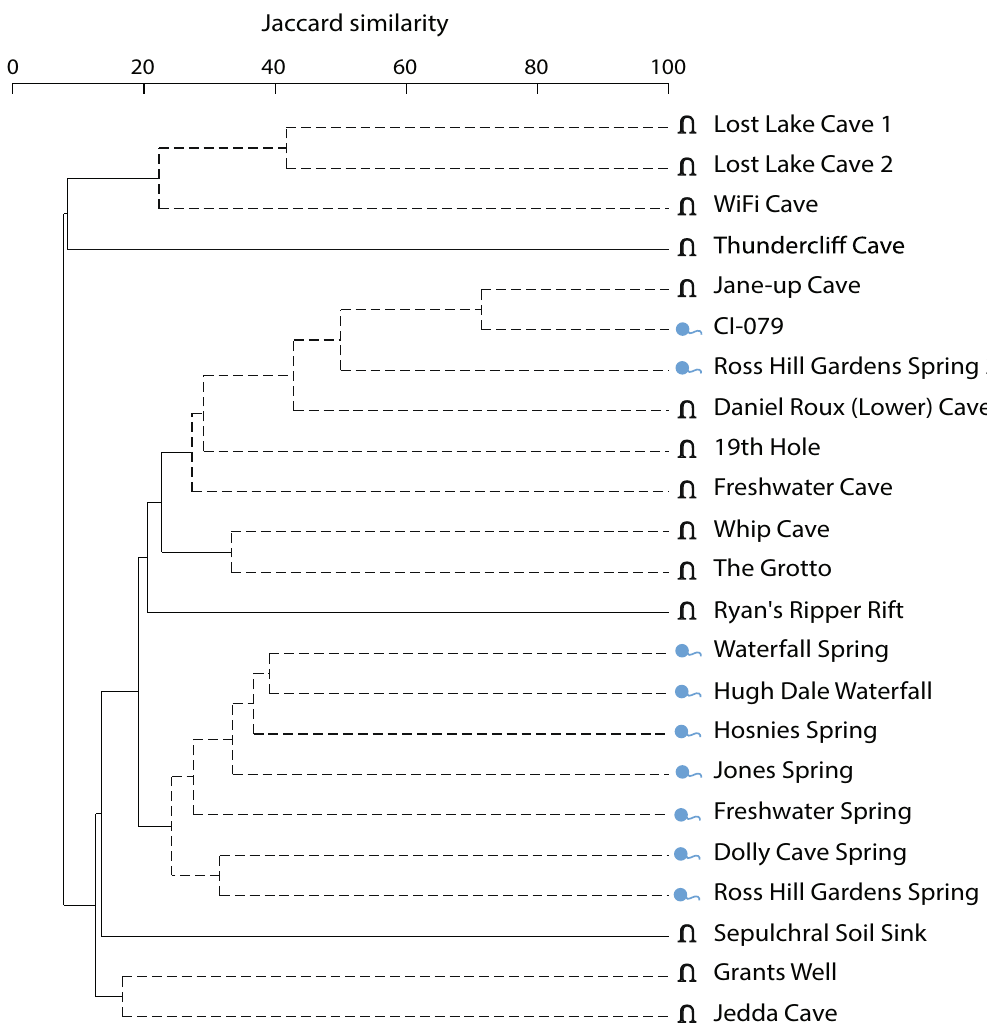
Figure 5. Cluster analysis of CI community composition similarity. Site composition is comprised of all assigned taxa resulting from the three metabarcoding assays. Solid lines indicate groups that the SIMPROF analysis identified were significantly different from each other ( P <